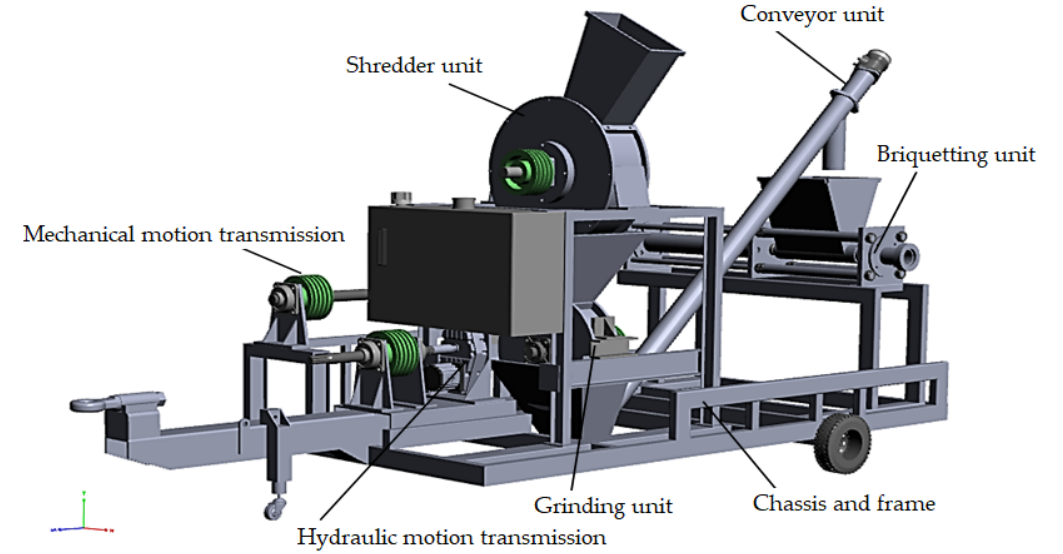
Figure 2. Prototype mobile briquetting machine driven by PTO, with hydraulic piston.